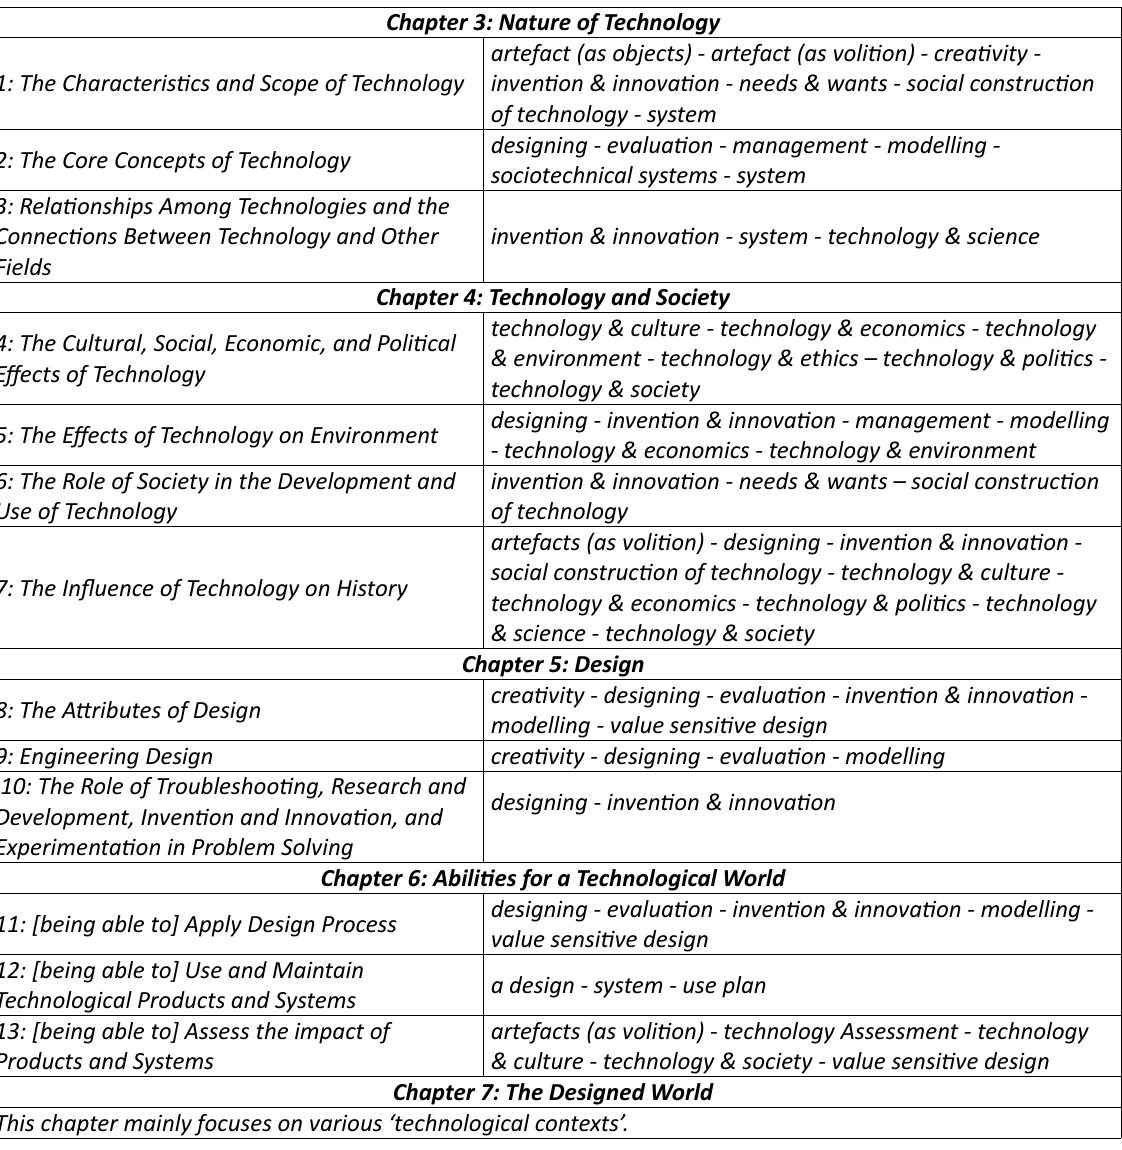
Table 3. The concepts and concerns related to the nature of technology, in